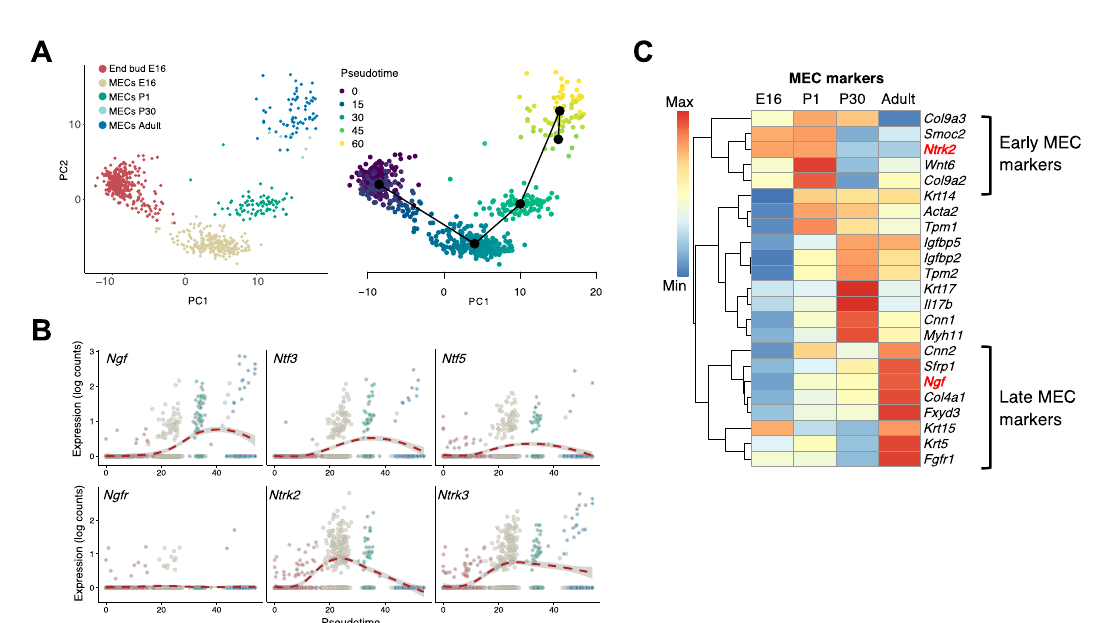
Fig. 3 Murine SMG is an ideal model to investigate neurotrophin signaling in healthy salivary glands and con fi rms that MECs are a major neurotrophin signaling hub. A Immunostaining of SMA in mouse SMG at embryonic days E16 and E17, and postnatal days P1 and P8. B scRNAseq from mouse SMG (GSE150327). C , D Balloon plot of expression of neurotrophin signaling genes in mouse SMG at selected developmental stages. E Immunostaining for SMA (red), TrkA, TrkB and TrkC (green) and nuclei (DAPI, blue) in mouse SMG at E16, P1 and P8. White boxes (a-c) are shown enlarged. Scale bar, 50 µm except c) Scale bar, 20 µm. F Representation of putative ligand-receptor interactions between MECs and other cell types via neurotrophin signaling genes. Arrows point from the source of ligands in the direction of the receptor and the thickness of the arrow is relative to the number of potential interactions between two cells. Analysis and plots generated with the LigandReceptor script available on GitHub (https://github.com/chiblyaa/LigandReceptor). A list of curated pairs was obtained from Ramilowski et al. 50 .